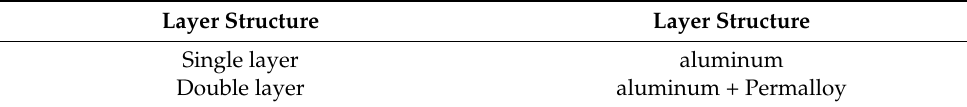
Table 1. Multi-layer structures.